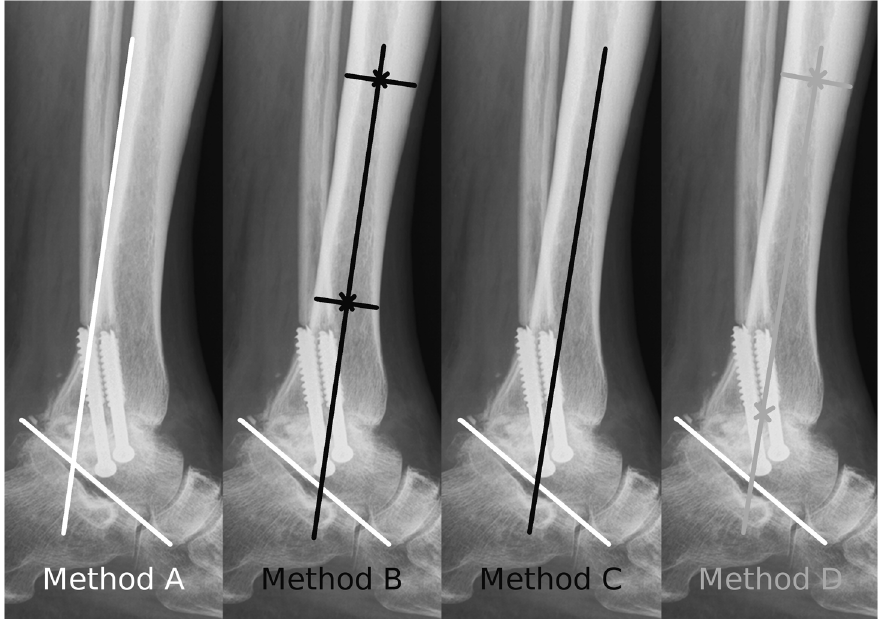
Fig 4. Measurement methods for the STTA. Diagrams depicting the four different methods for drawing the longitudinal axis of the tibia for STTA measurement on lateral ankle radiographs.